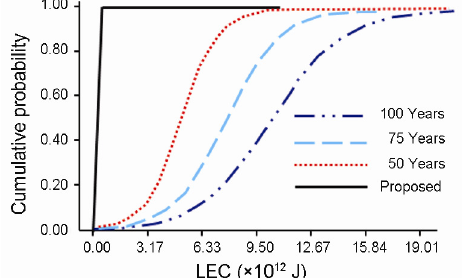
Fig. 17. Comparison of the results from different methods (Cumulative distribution